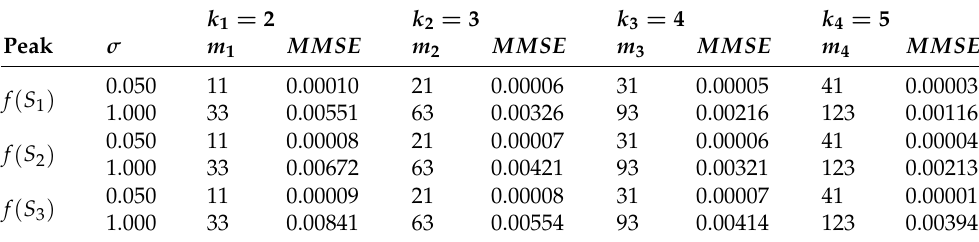
Table 1. Effect of filter order on the estimation